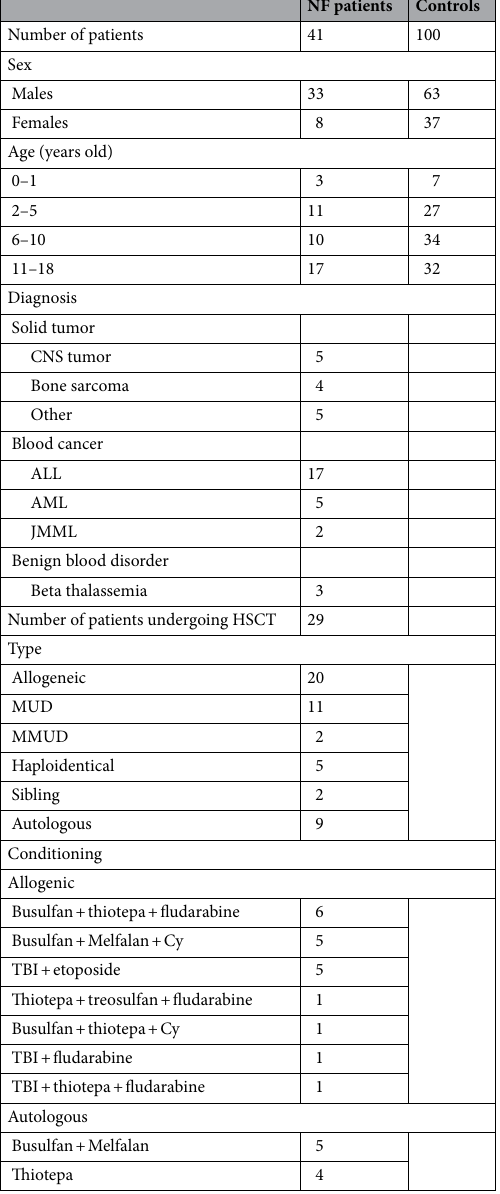
Table 1. Characteristics of the study patients (CNS = central nervous system; ALL = acute lymphoblastic leukemia; AML = acute myeloid leukemia; JMML = juvenile myelomonocytic leukemia; MUD = matched unrelated donor; MMUD = mismatched unrelated